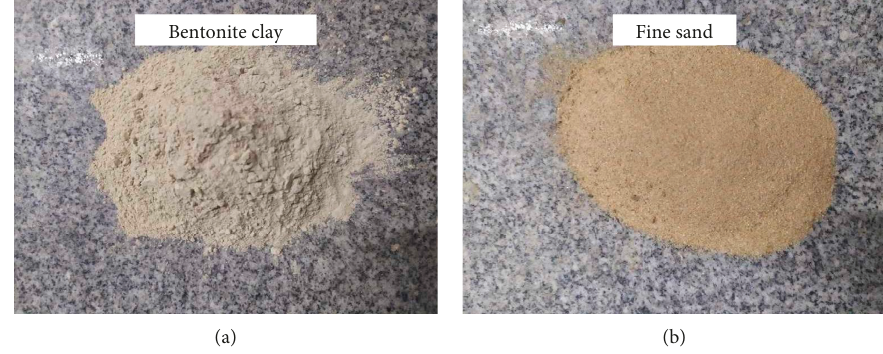
Figure 6: Soil composition: (a) bentonite clay; (b) fine